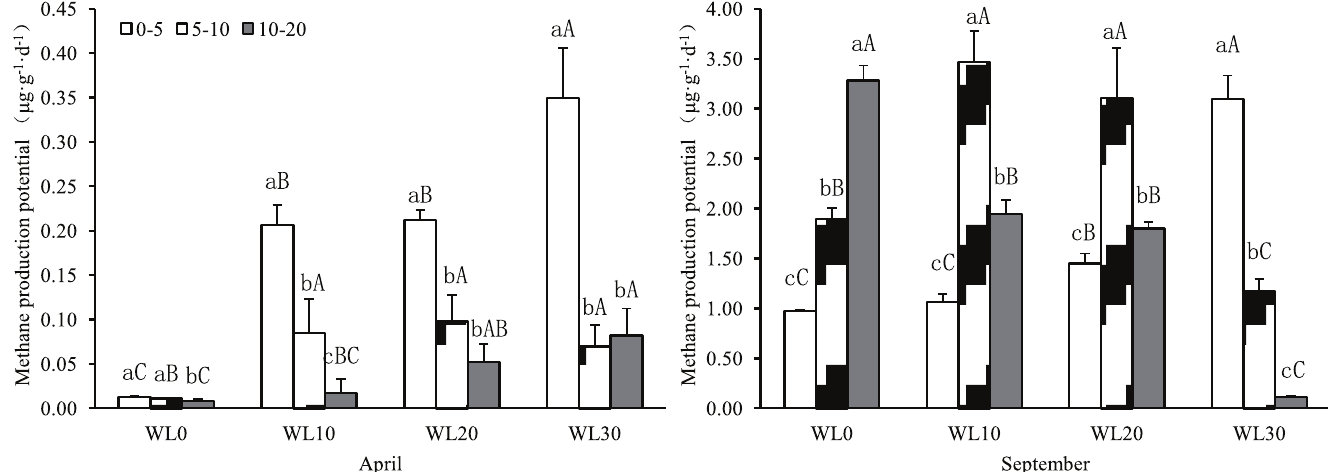
Fig 3. CH 4 production potential at various water levels in the Hangzhou Bay Wetland. ( Different lowercaseletters indicate differences betweensoil layers for a particularwater level ( p < 0.05); different upper letters indicate differences betweenwater levels within a soil layer ( p < 0.05)).